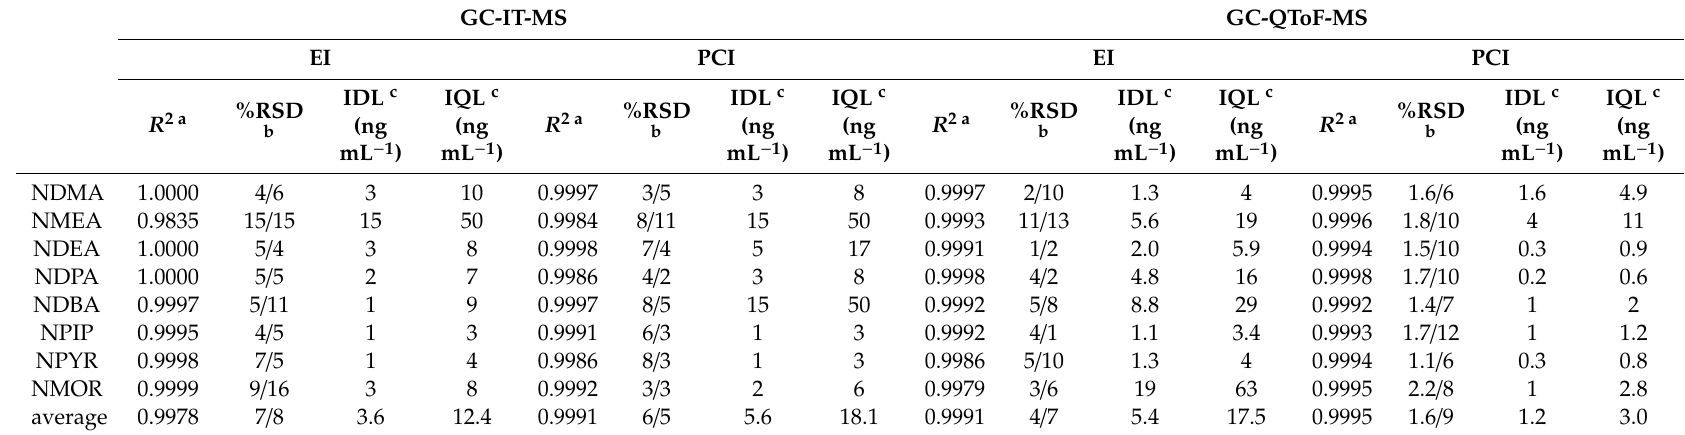
Table 2. Gas chromatography-mass spectrometry (GC-MS) performance for both instruments using EI and PCI sources. Note: IDL = instrumental detection limit; IQL = instrumental quantification